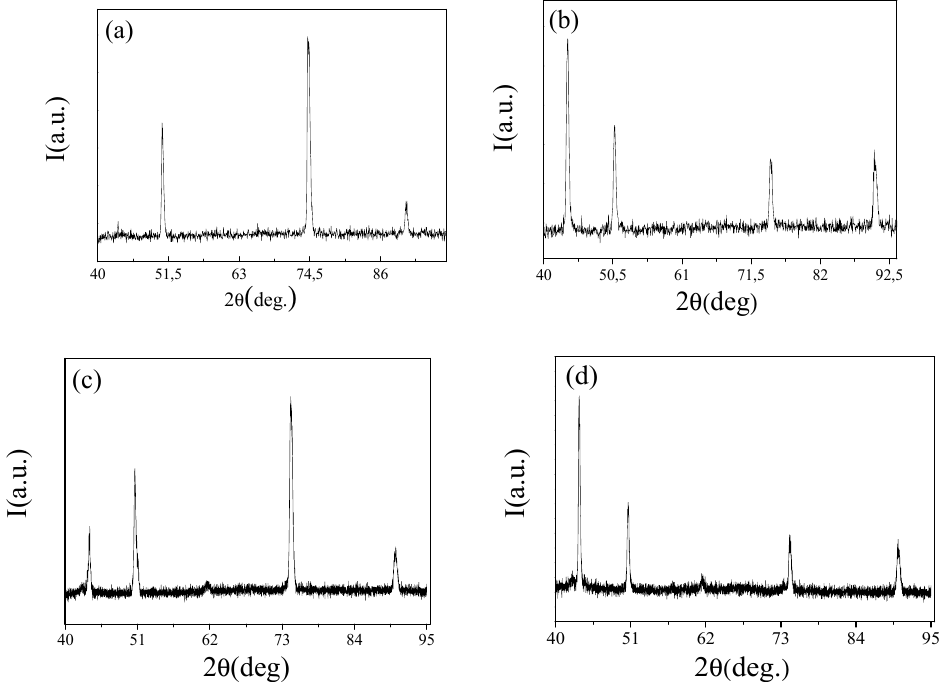
Figure 22. XRD of as-prepared ( a , b ) and annealed at Tann = 400 °C for 24 h ( c , d ) Cu 95 Co 5 and Cu 80 Co 20 microwires respectively. Reproduced from reference [85], Figure 2.